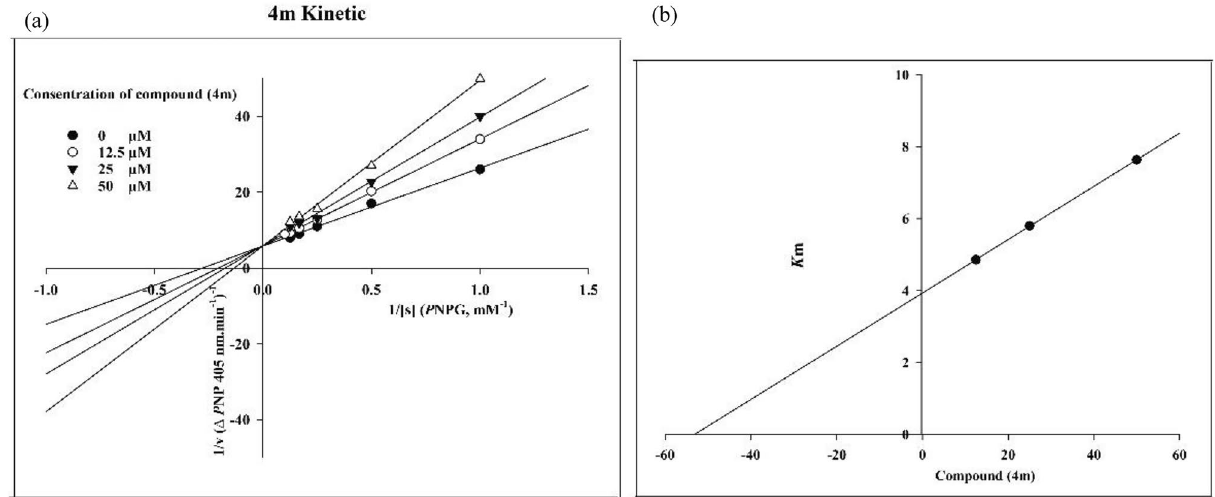
Figure 6. Kinetic study of the most potent inhibitor 4m against α-glucosidase; ( a ) Lineweaver–Burk plot and ( b ) double reciprocal Lineweaver–Burk plot (Exel 2013).